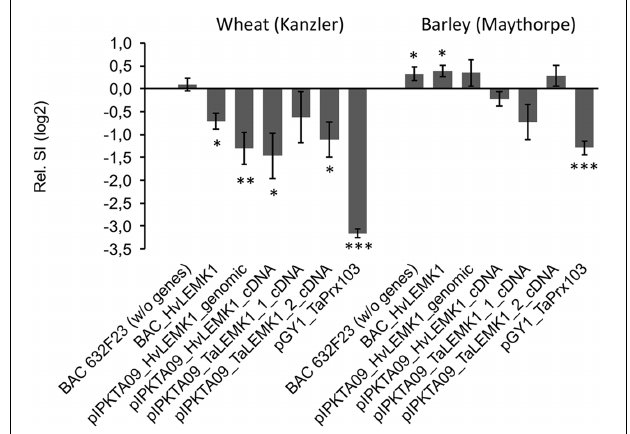
FIGURE 6 | Effect of transiently expressing LEMK1 genes in barley and wheat on quantitative host resistance against adapted powdery mildew fungi. Barley and wheat orthologs of LEMK1 were transiently expressed in bombarded barley and wheat leaf segments, followed by inoculation with the adapted powdery mildew fungi Bgh and Bgt , respectively. In the case of HvLEMK1 , the gene was expressed under the control of its own promoter by bombarding an HvLEMK1 -containing BAC clone, and under the control of the CaMV 35S promoter as genomic BAC sub-clone (pIPKTA09_HvLEMK1_genomic) or full-length cDNA clone (pIPKTA09_HvLEMK1_cDNA). The corresponding wheat orthologs TaLEMK1_1 and TaLEMK1_2 were only expressed as full-length cDNA clones under the control of the CaMV 35S promoter (pIPKTA09_TaLEMK1_1_cDNA; pIPKTA09_TaLEMK1_2_cDNA). pGY1_TaPrx103 for over-expression of a pathogen-induced wheat class III peroxidase (Schweizer, 2008) and BAC632F23 containing no annotated genes served as positive and negative controls, respectively. SI values were normalized to the empty over-expression vector pIPKTA09 and log(2) transformed. Mean values ± SEM of 5–10 independent experiments (pGY1_TaPrx103 in barley, 21 experiments) are shown. ∗ p < 0.05, ∗∗ p < 0.01, ∗∗∗ p < 0.0001 (1-sample t -test against the hypothetical control value “0,”